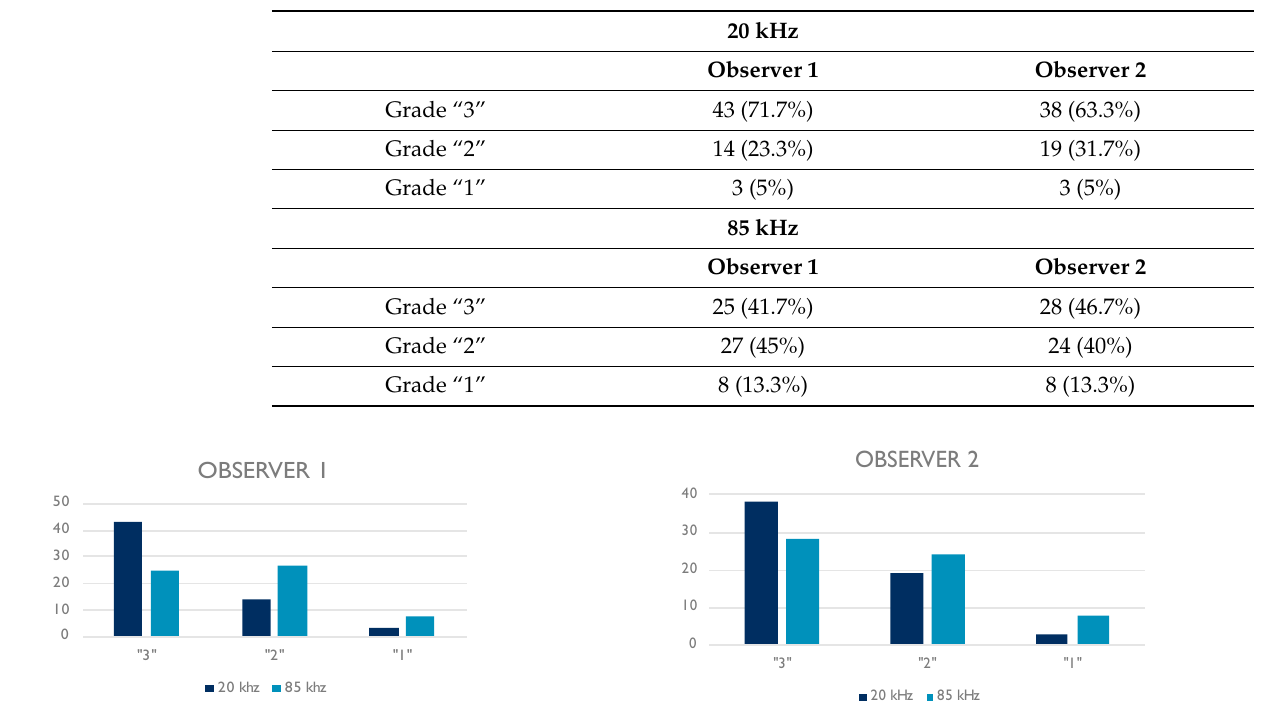
Figure 4. Histograms showing the qualitative assessments provided by each observer to the 20 kHz and 85 kHz OCT images.